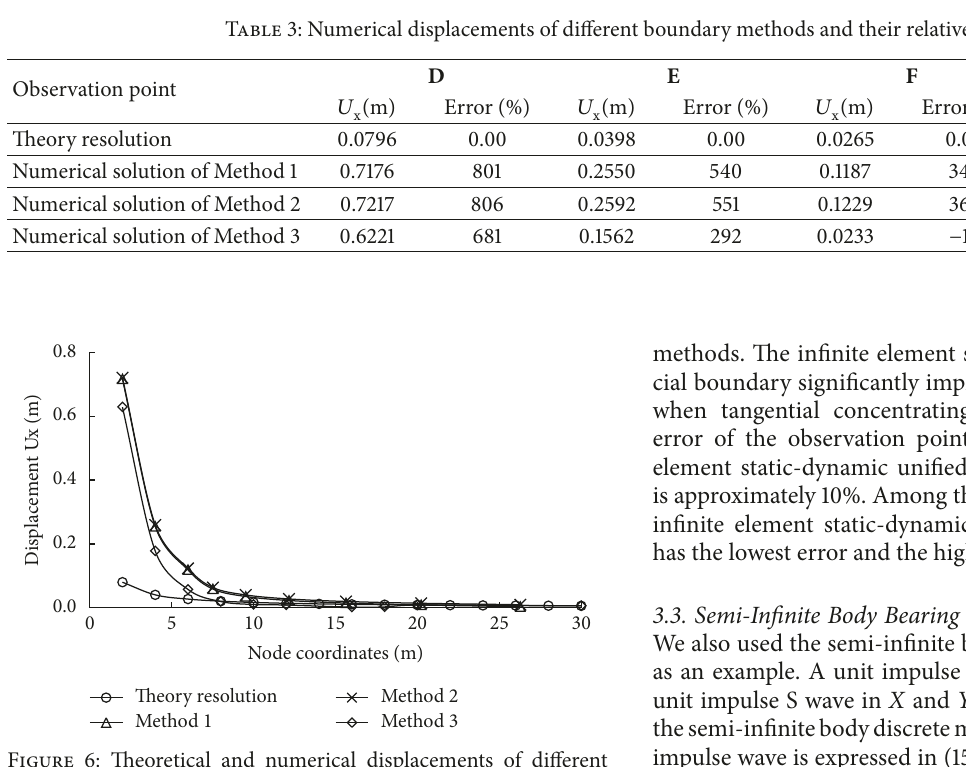
Figure 6: Theoretical and numerical displacements of different boundary